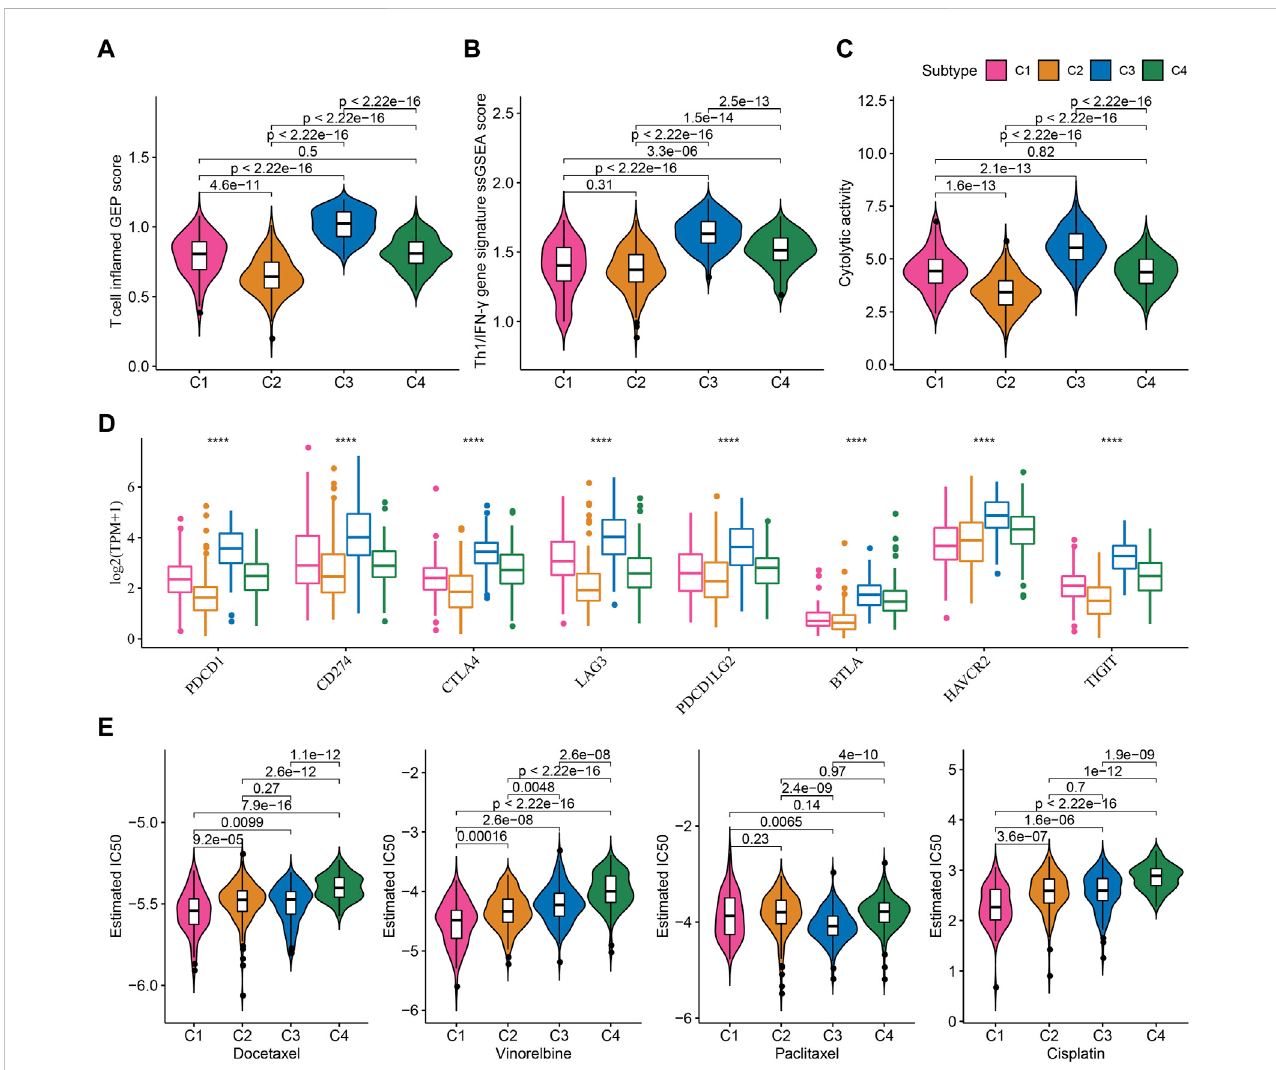
FIGURE 5 Predictionof the response to immunotherapy and chemotherapeutic drugs in TCGA dataset (A – C) The ssGSEA score of T cell in fl amed GEP, Th1/IFN- γ , and cytolytic activity in four subtypes (D) The expression of immune checkpoint genes in four subtypes (E) The estimated IC50 of four chemotherapeutic drugs in four subtypes. **** p <